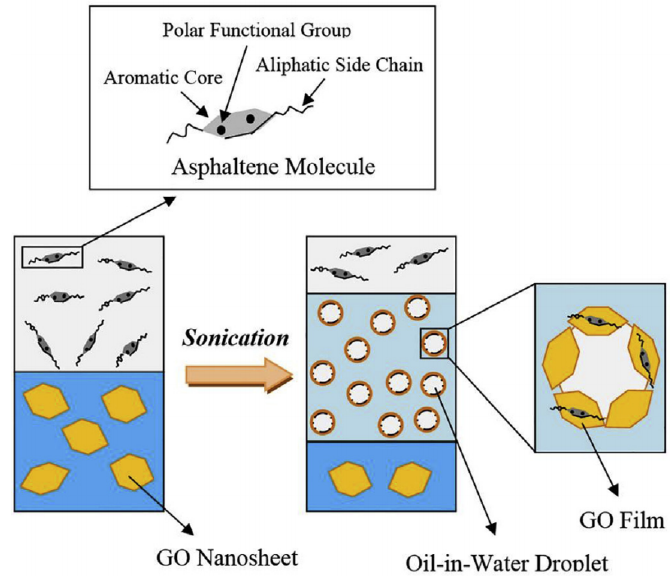
Figure 3. Schematic of emulsification process. (Reproduced with permission from [87]. Elsevier, 2019).